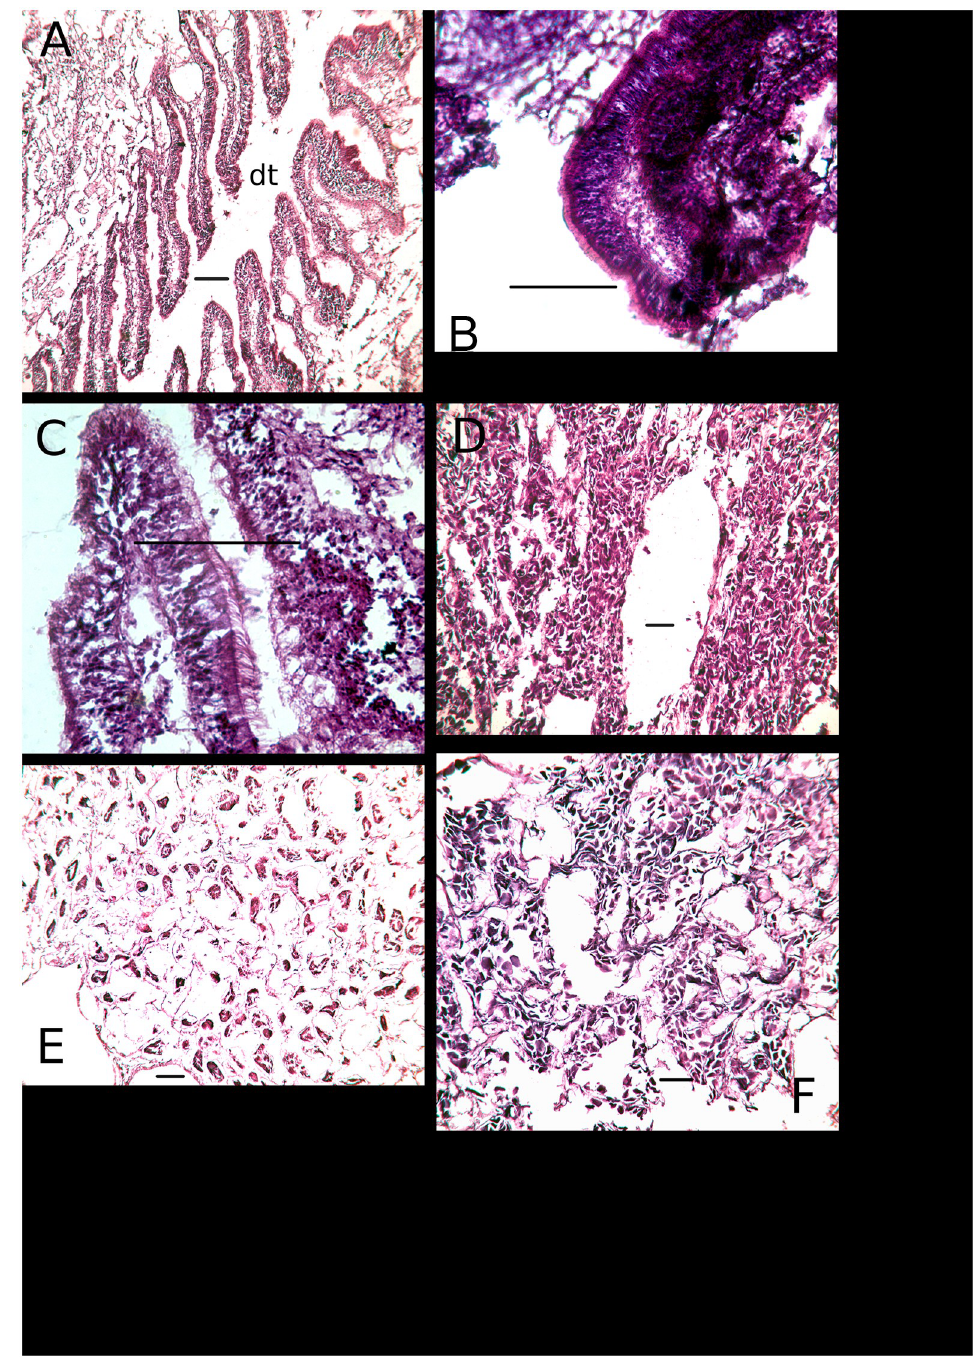
Fig 4. Digestive tract histologies. A-C, Normal digestive diverticula of three individuals from Chesapeake Bay. A illustrates the digestive tract (dt) and diverticular branches, and B and C exhibit ciliated columnar epithelia lining the diverticula. exhibiting ciliated columnar epithelia. D-F, three individuals from Barataria Bay, Louisiana, displaying atrophy and vacuolization of tissue resulting in breakdown of epithelial integrity. D—digestive tract with atrophied diverticula. E—epithelium along the digestive tract showing a loss of epithelial integrity. F—A digestive tract consisting of multiple atrophied tubules. Scale bars in all images are 100 μ m.